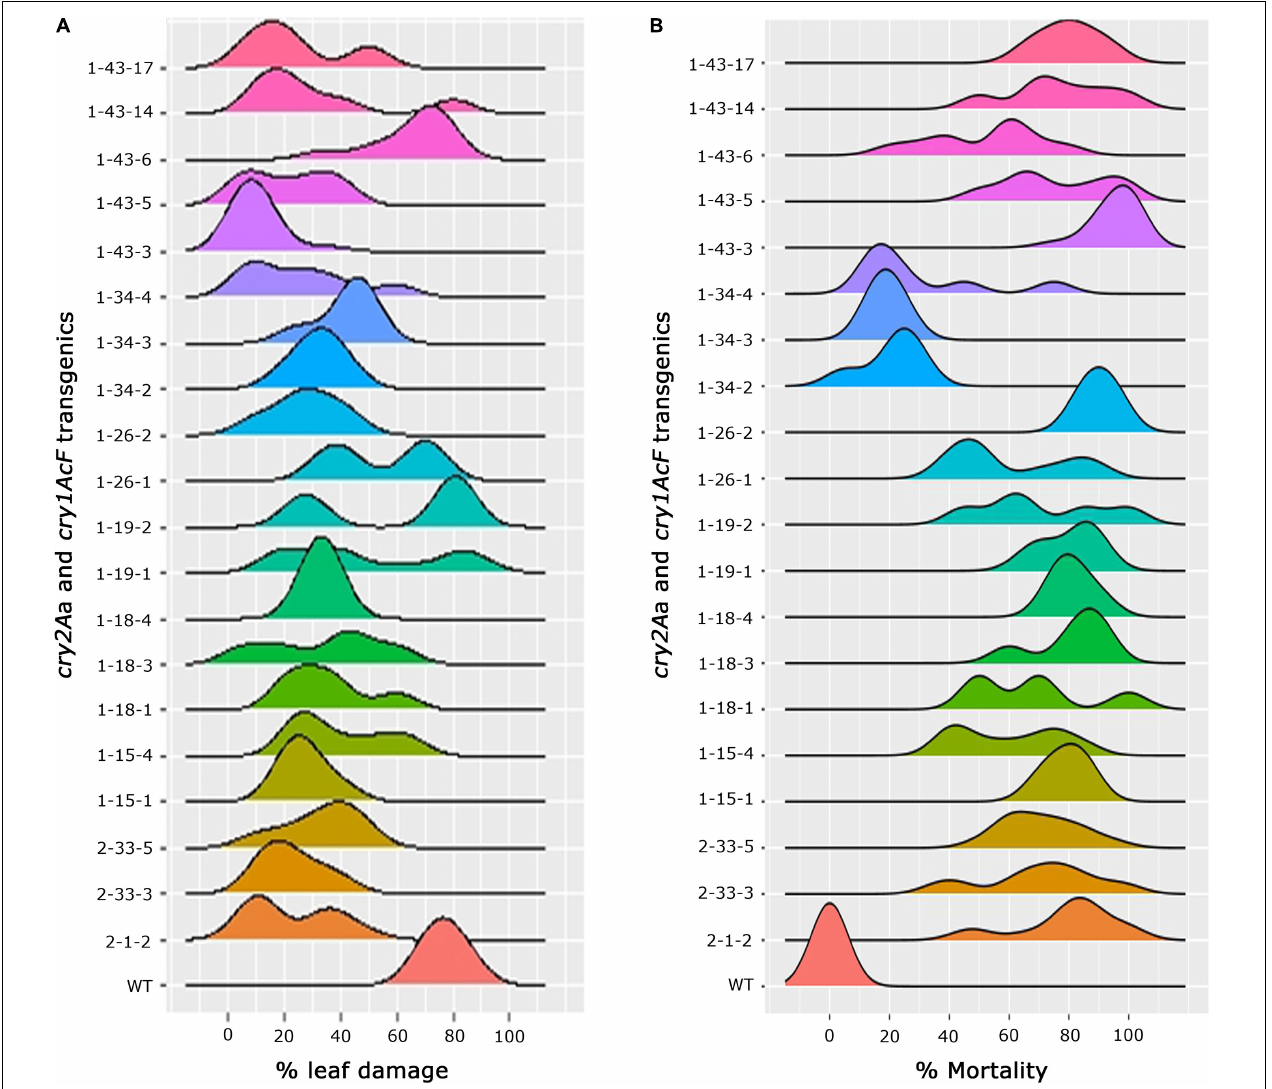
FIGURE 6 | Overview of efficacy analysis of T 2 generation progeny plants of cotton transformants harbouring cry1AcF and cry2Aa (A) percentage of leaf damage and (B) percentage of larval mortality.